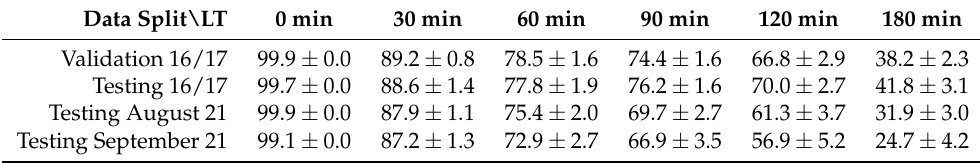
Table 5. CSI of our method for various data sets, SR 30.61km and varying lead time